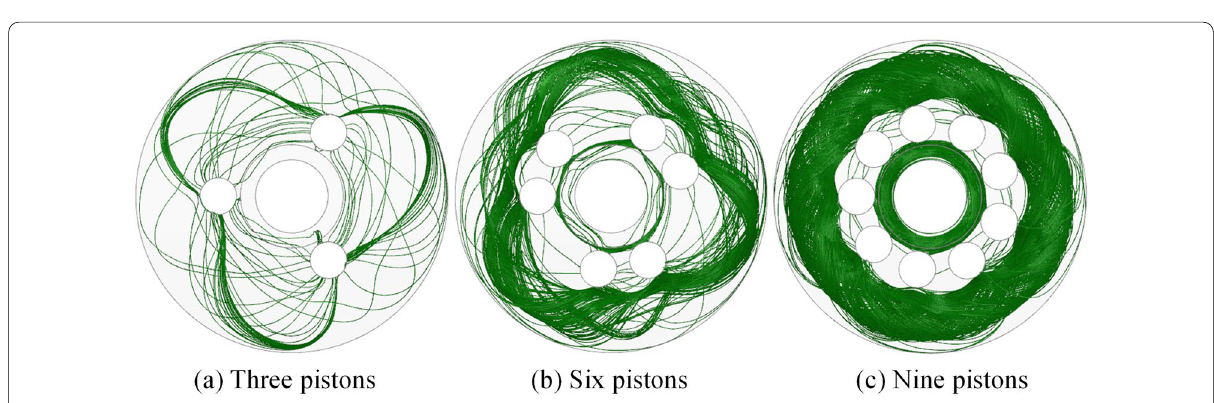
Figure 7 Streamline in fluid